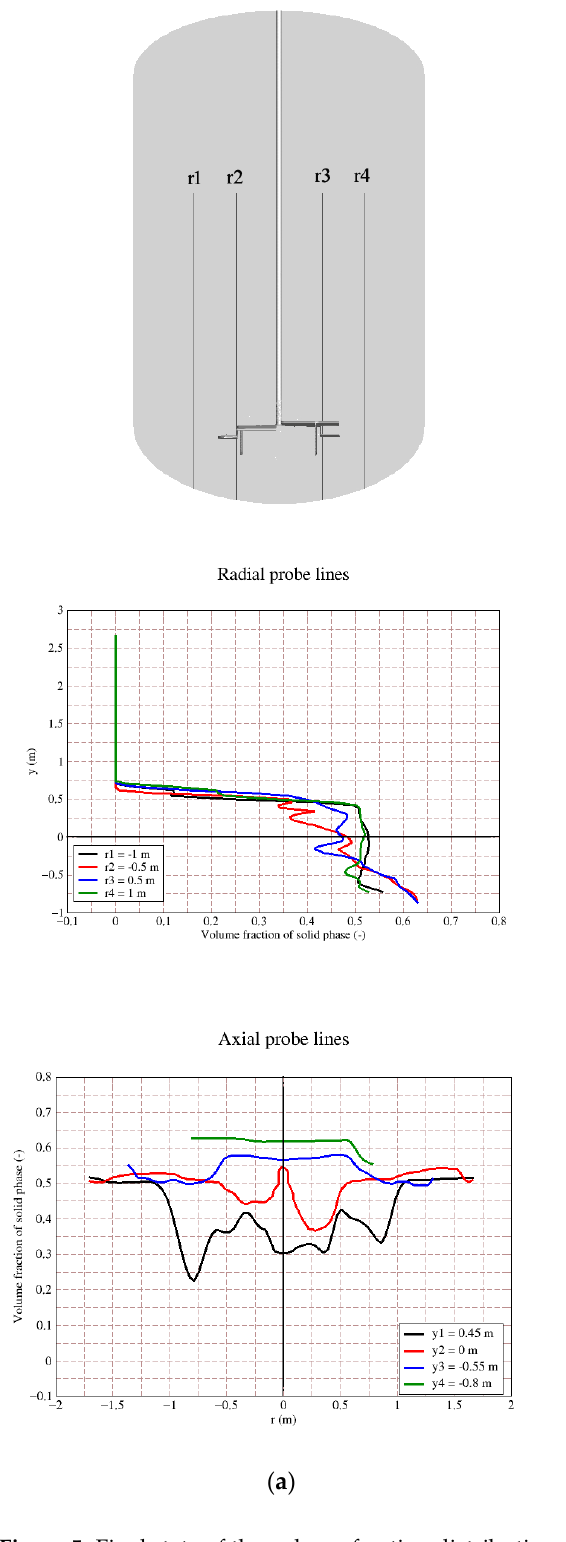
Figure 5. Final state of the volume fraction distribution of the solid phase axially and radially: ( a ) flow started from the solid phase fully sedimented; ( b ) flow started from the solid phase dispersed in the entire volume of